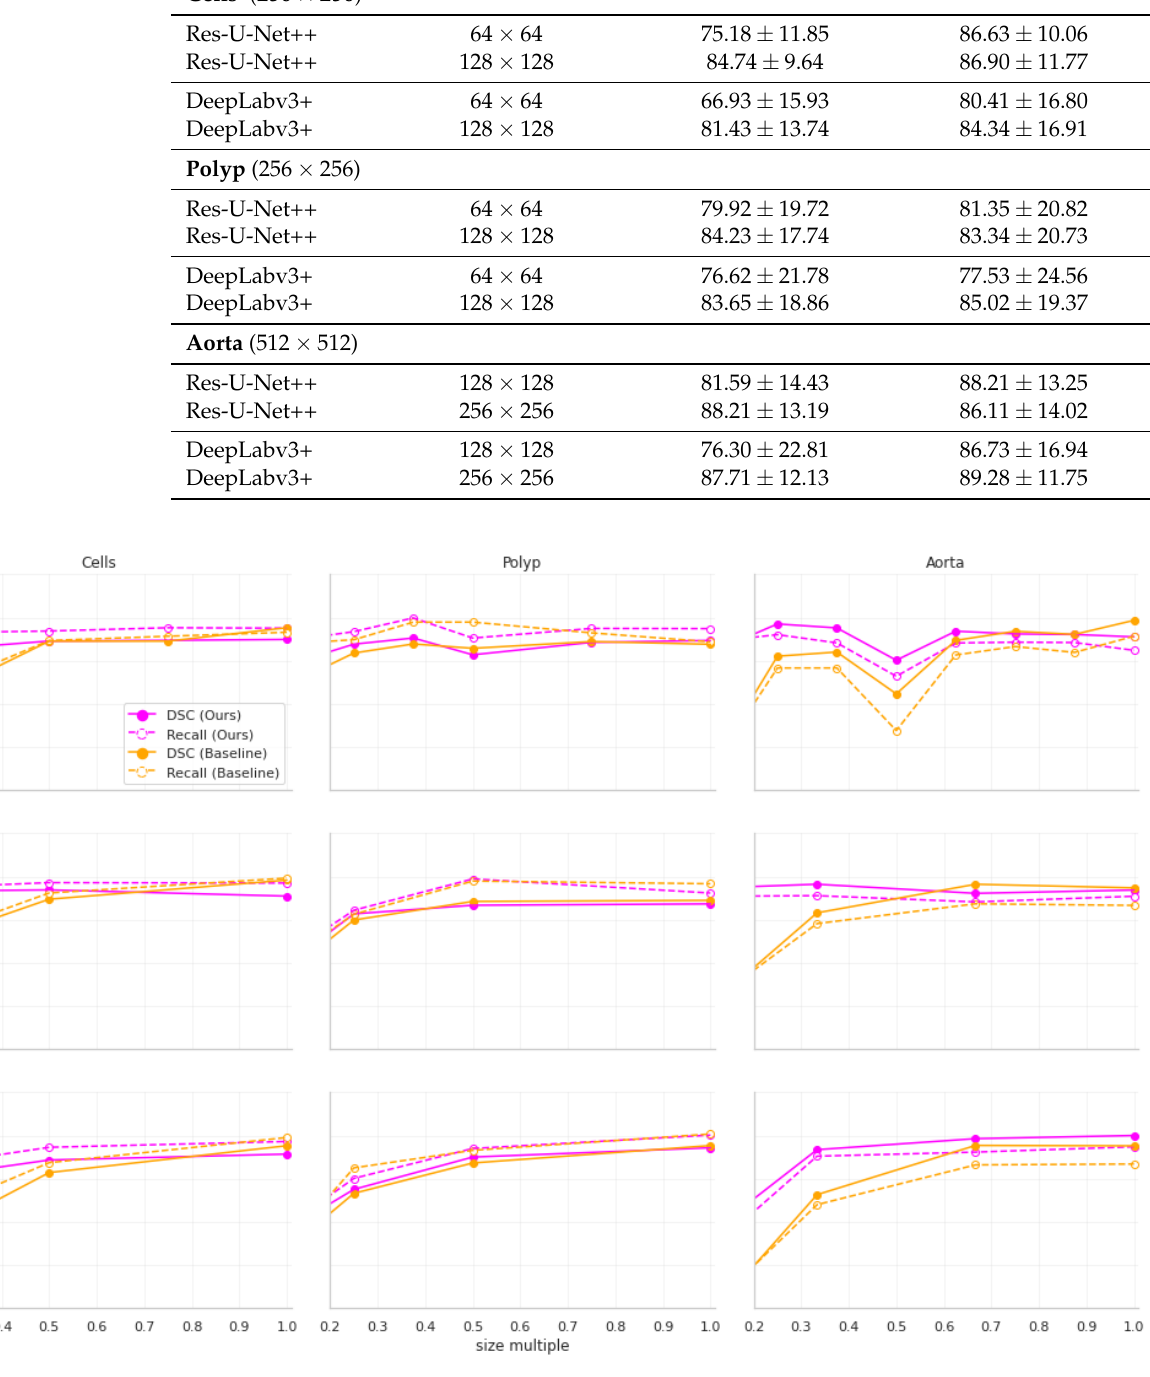
Figure 2. The relationship between input dimensions and the mean Dice Score Coefficient (DSC) and recall for different datasets. The points are measured values from our